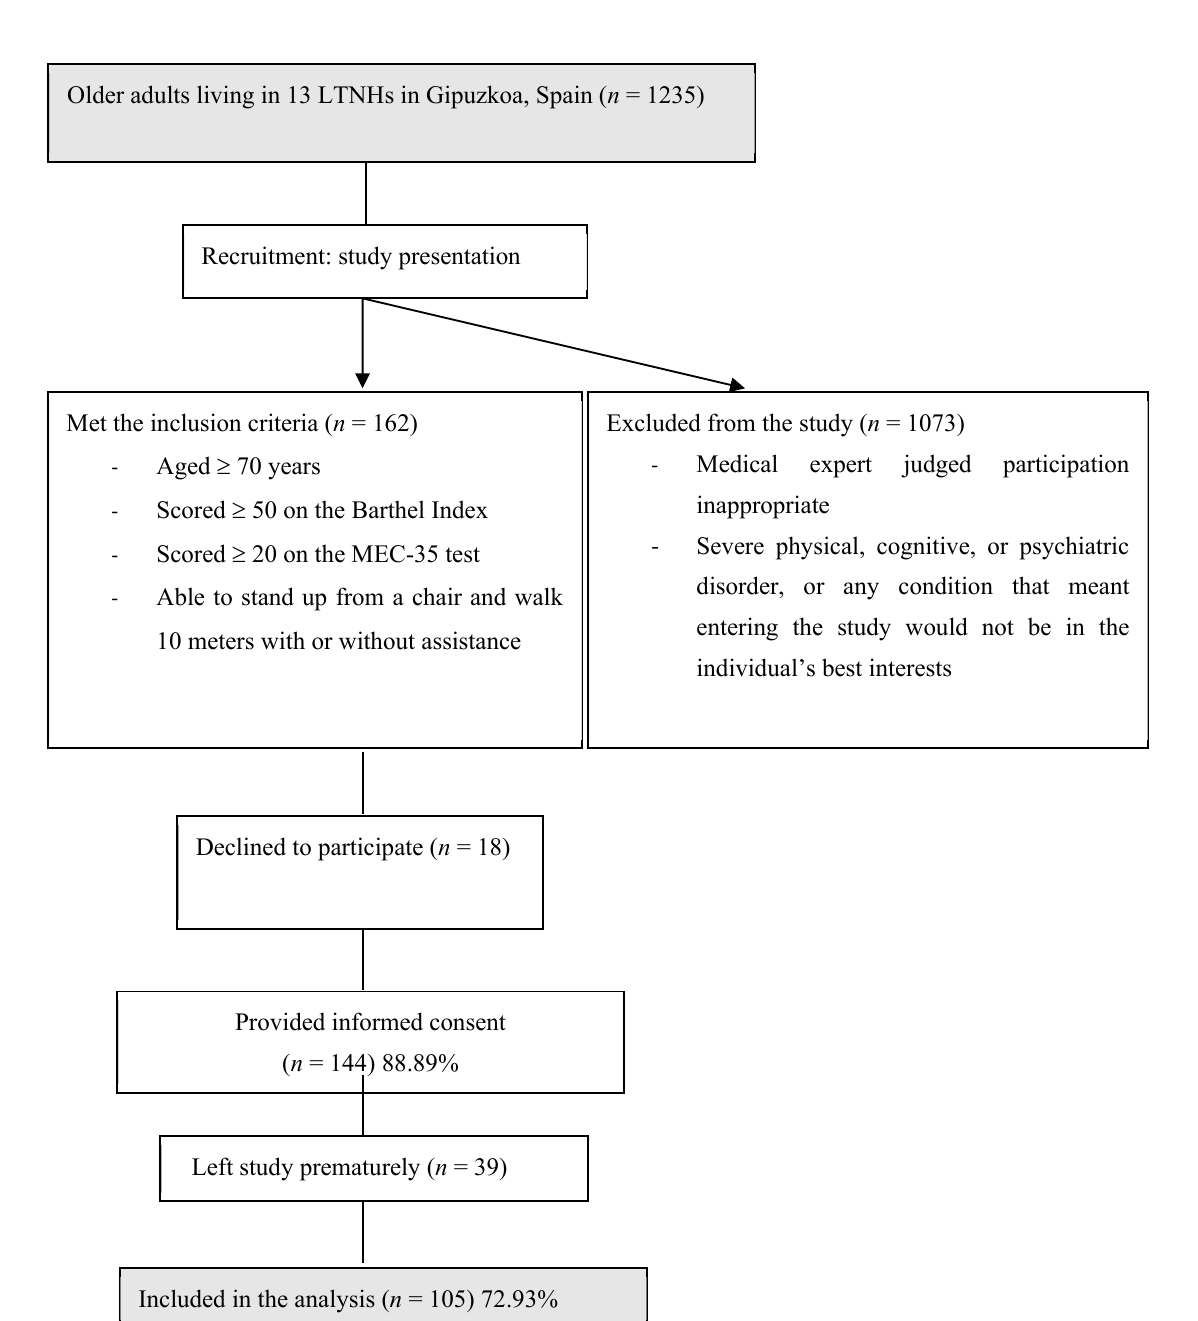
Figure 1. Study flow diagram.